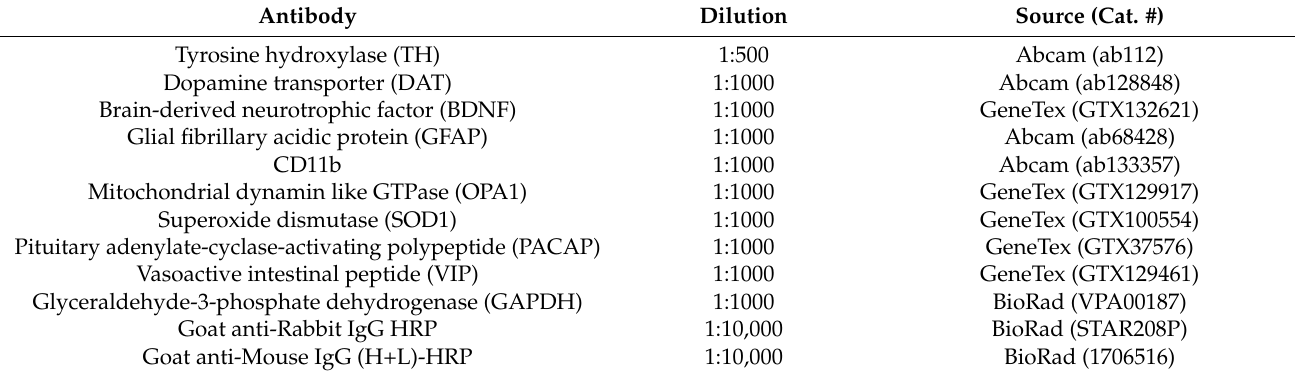
Table 2. List of primary and secondary antibodies used in Western